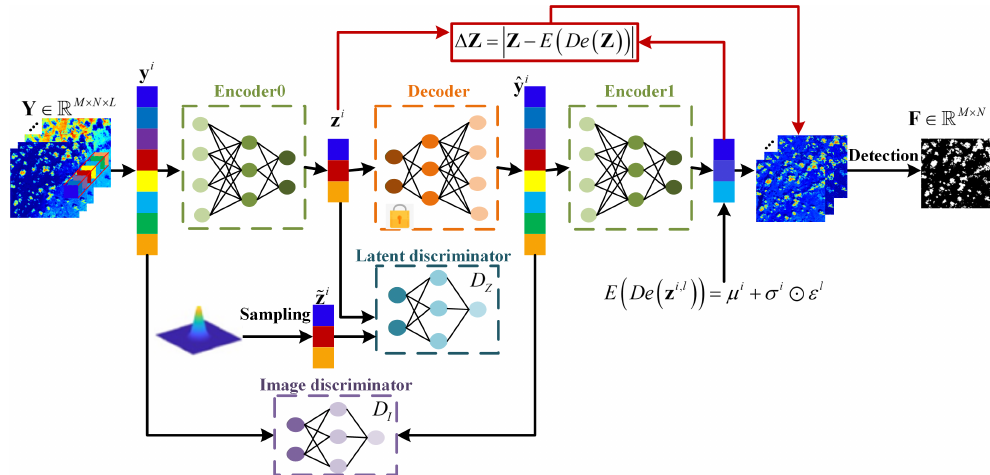
Figure 1. The detailed description of the proposed unsupervised network for cloud detection (UNCD) in remote sensing